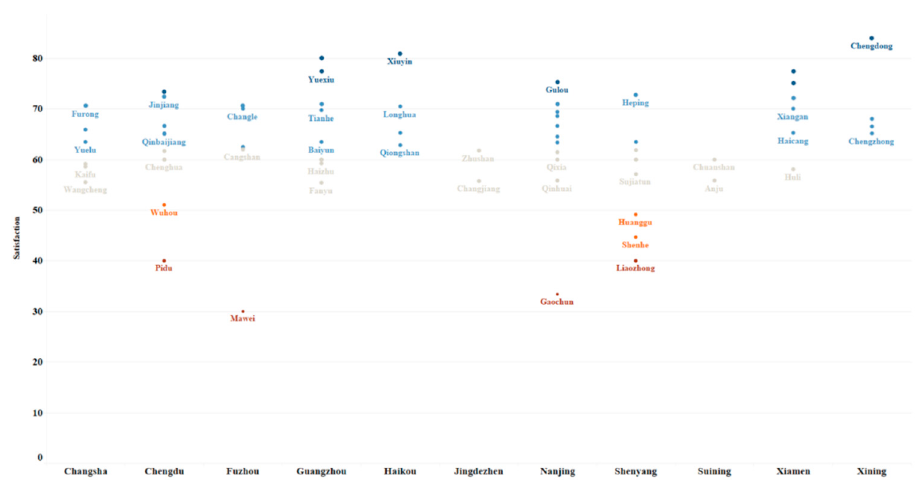
Figure 4. Evaluation of the FPHEB’s PUPS in different districts.